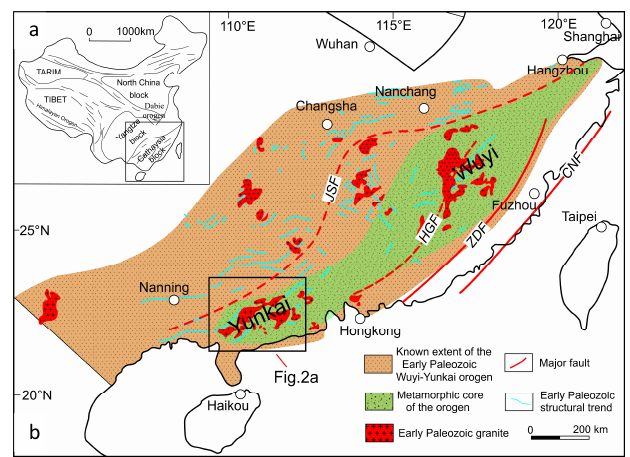
Figure 1. ( a ) Geological map of China (modified after [46]). ( b ) Simplified regional map with highlighted regions showing the Early Paleozoic Wuyi–Yunkai orogen; JSF = Jiangshan–Shaoxing fault; HGF = Heyuan–Guangfeng fault; ZDF = Zhenghe–Dapu fault; CNF = Changle–Nanao fault (modified after [30,31,41,47]).